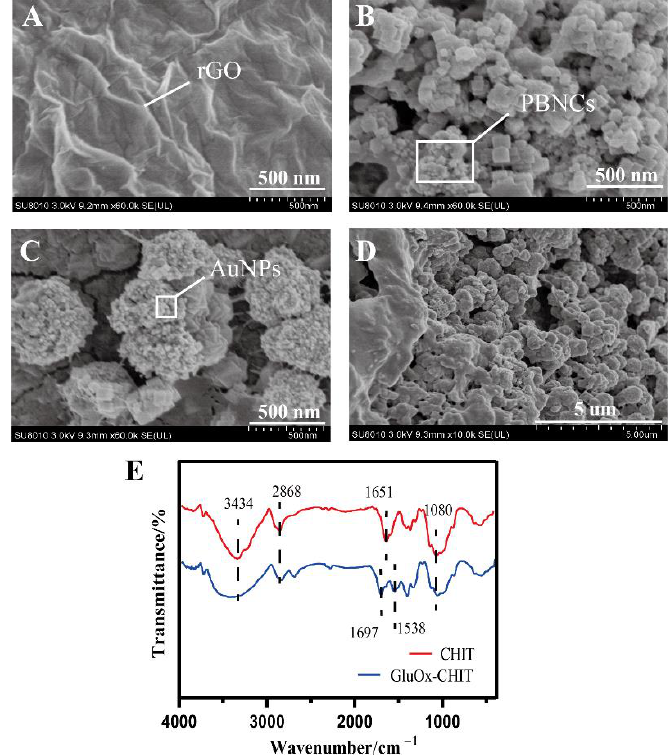
Figure 2. FE-SEM images at different phases of the modified processes of the electrodes. ( A ) rGO-Pt, ( B ) PBNCs / rGO-Pt, ( C ) AuNPs / PBNCs / rGO-Pt, and ( D ) modified electrode. ( E ) FTIR spectra of CHIT-Pt electrode (red curve) and GluOx-CHIT electrode (blue curve).